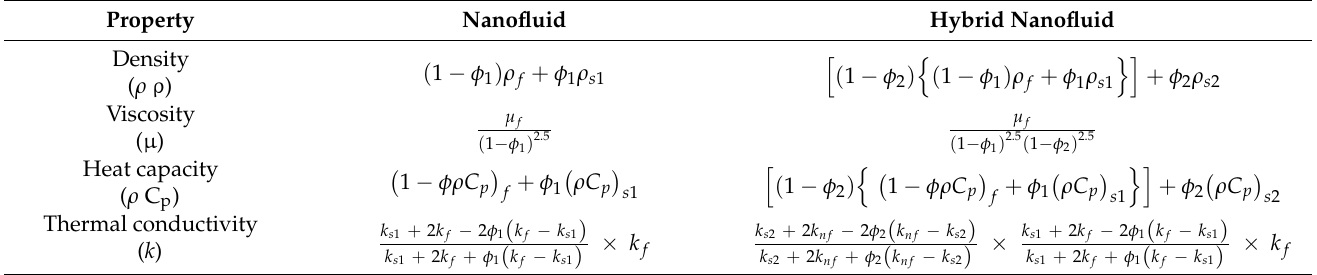
Table 8. Models applied for thermophysical properties of nanofluids and hybrid nanofluids